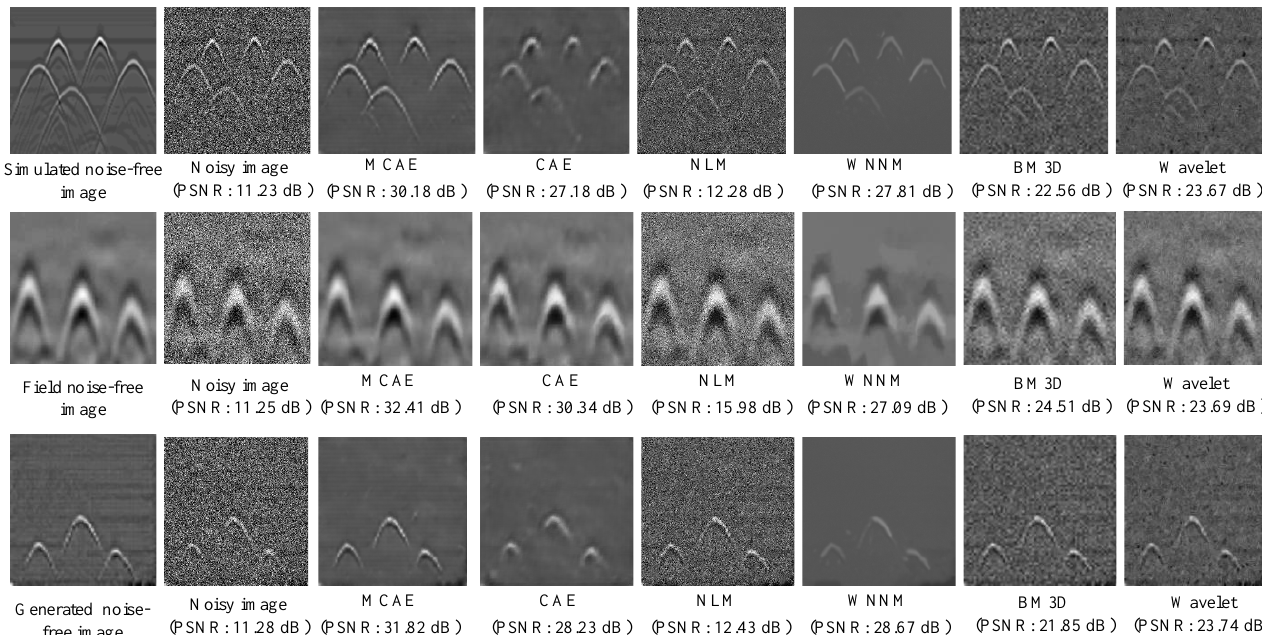
Figure 8. Denoising results on images by different methods (noise level σ = 30).